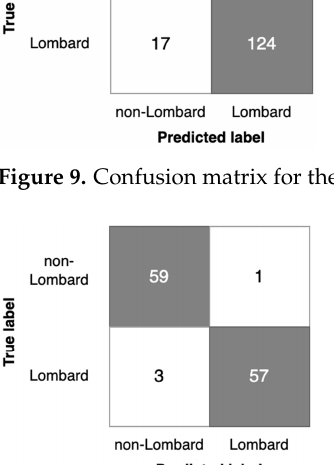
Figure 10. Confusion matrix for the P1 model. Model value separation can be visualized using scatter plots, presenting all recog- nized (detected) speech types with their average detection score. Separation plots are pre- sented in Figure 11.